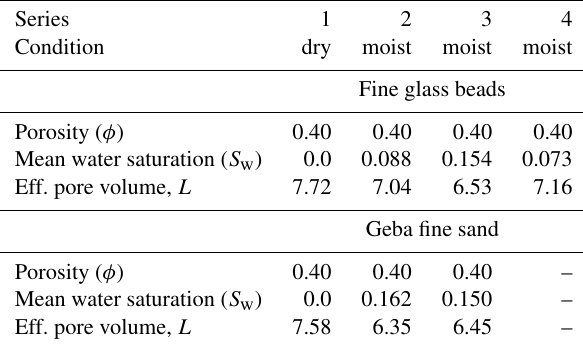
Table 3. Experimental conditions of vapor-retardation experiments in fine glass beads and Geba fine sand in dry and moist conditions (series).